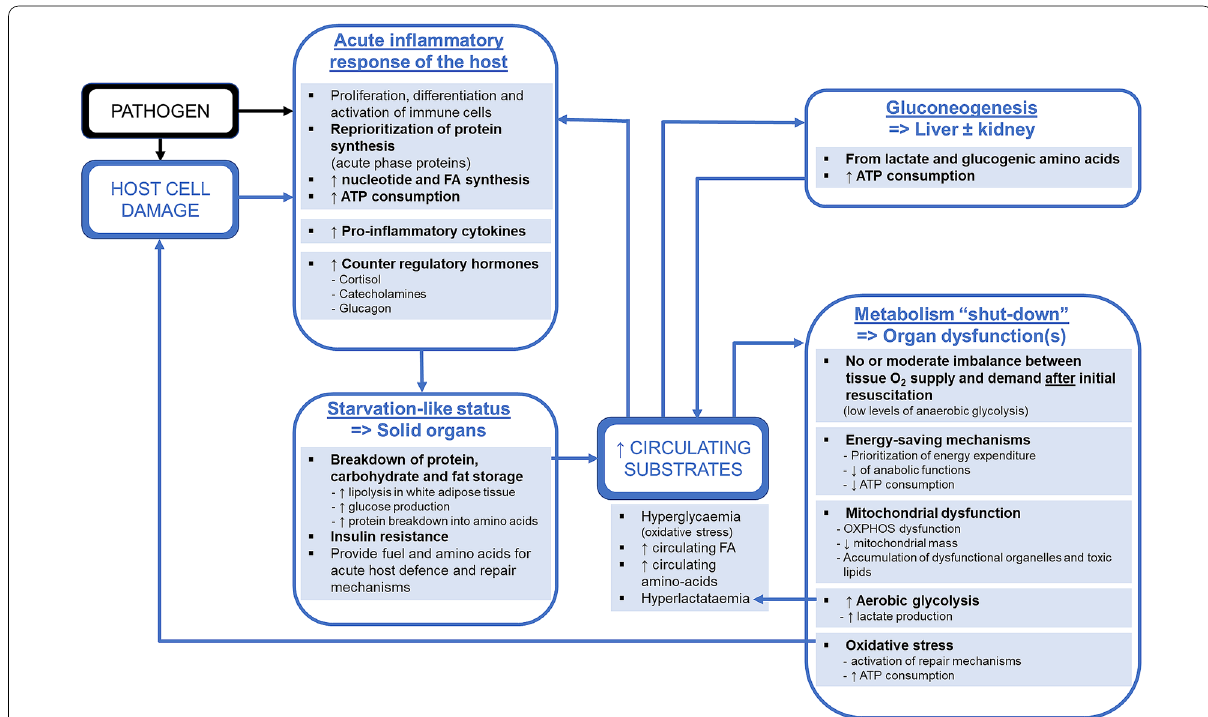
Fig. 2 Major changes in substrate uptake and utilization in patients with sepsis. ATP adenosine triphosphate, FA fatty acids, O 2 oxygen, OXPHOS oxidative